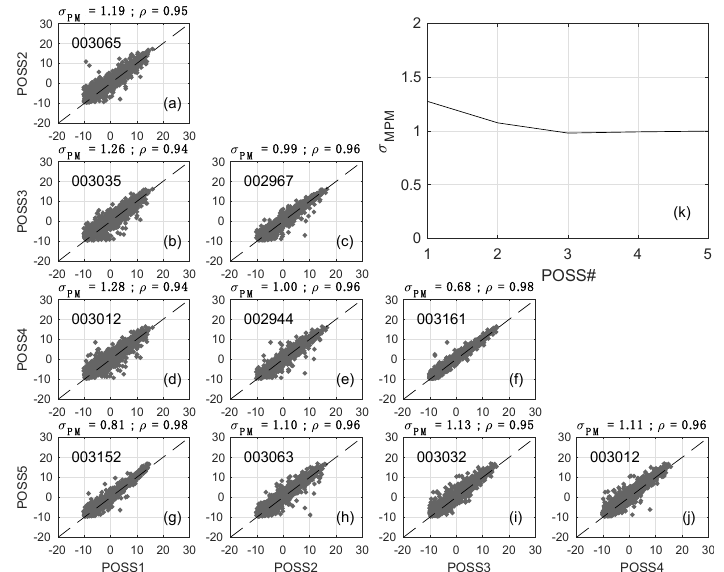
Figure 7. ( a )–( j ): scatterplot of rainfall rate (dBR) calculated from five POSS disdrometers. The corresponding values of the measurement error ( σ ) from paired measurements and the correlation coe ffi cient ( ρ ) are shown on the top of each panel. The standard deviation of the measurement noise ( σ ) from multiple paired measurements are shown in ( k ).